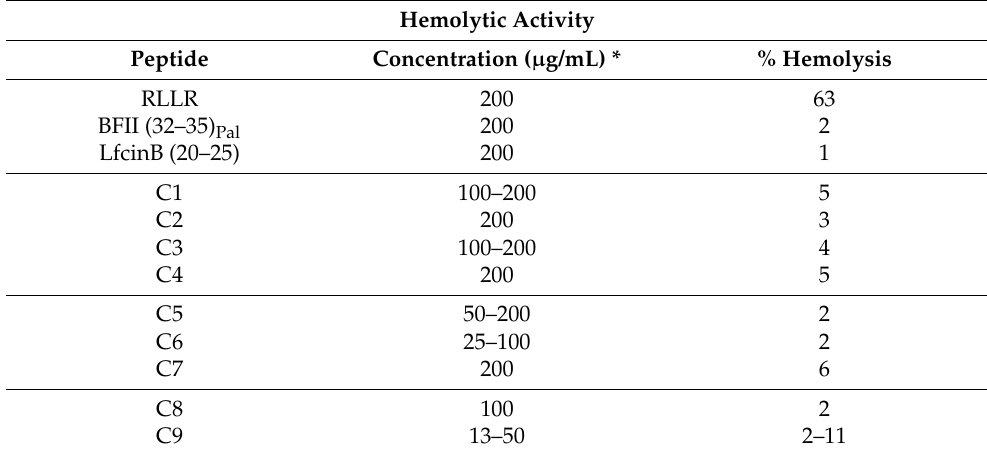
Table 3. Hemolysis percentage for control peptides and peptide chimeras.